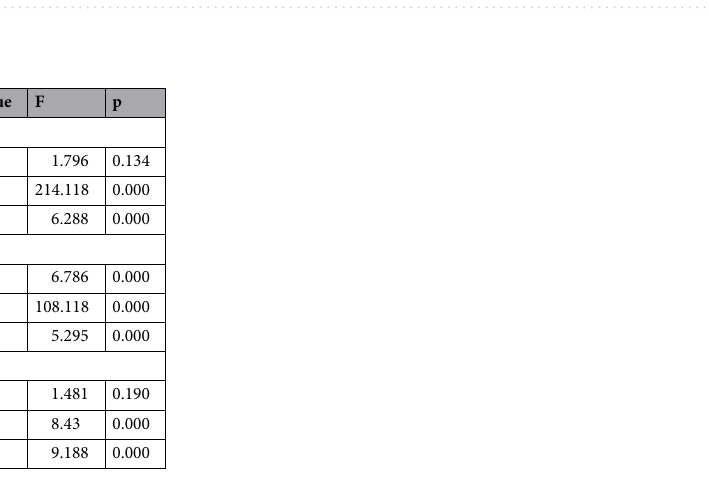
Table 4. Selected elements levels (mg kg −1 dry weight) in the muscle tissue of the sea trout ( Salmo trutta m. trutta L.) during different developmental stages. See as Table 1.